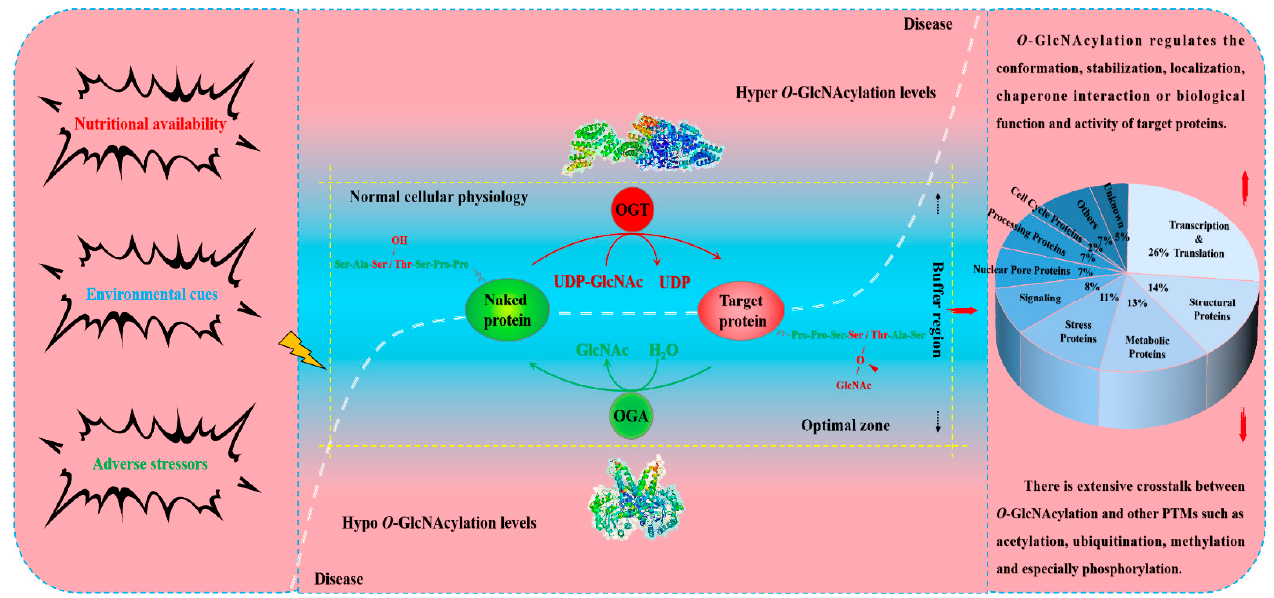
Figure 1. Protein O -GlcNAcylation homeostasis is maintained by its only pair of process enzymes, OGA and OGT. To date, thousands of proteins have been identified as O -GlcNAcylated, and these proteins are diverse including enzymes, transcription factors, signaling proteins, mitochondrial proteins, among others. O -GlcNAcylation homeostasis of these proteins is precisely and rapidly regulated only by OGT and OGA. Faced with mild stress and acute adverse stimulation, OGT and OGA form a “buffer” to make O-GlcNAcylation fluctuate adaptively within the “optimal zone”. Strong stress or chronic adverse stimulation beyond the buffer threshold of OGT and OGA results in O -GlcNAcylation levels exceeding the optimal zone. Both hyper- and hypo- O -GlcNAcylation beyond the “buffer region” lead to cellular dysfunction and other harmful effects.